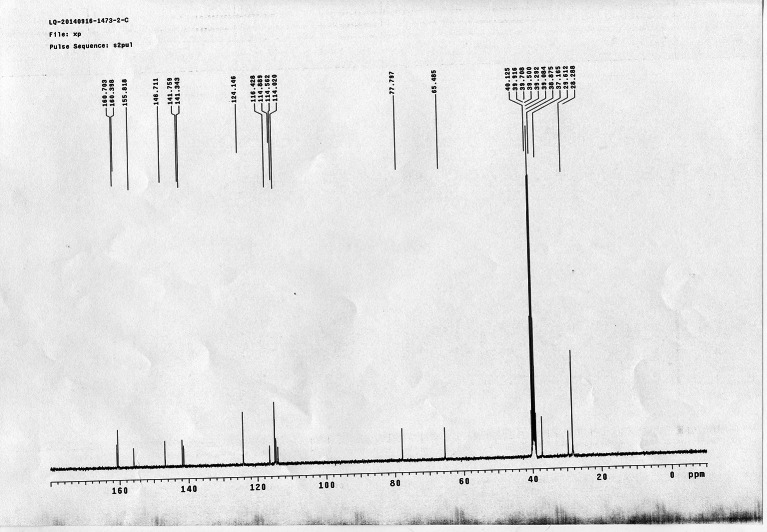
13C NMR spectra of compound 23.